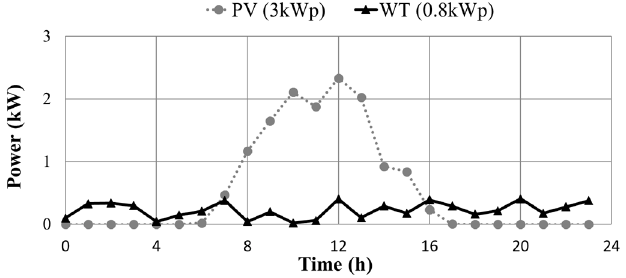
Figure 4. Twenty-four-hour photovoltaic system and wind turbine power production. PV: photovoltaic; WT: wind turbine.